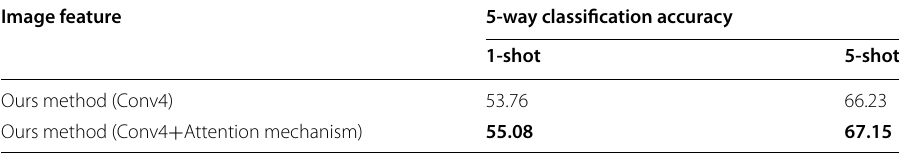
Table 5 Comparison of the embedded module in miniImageNet dataset (%) Image